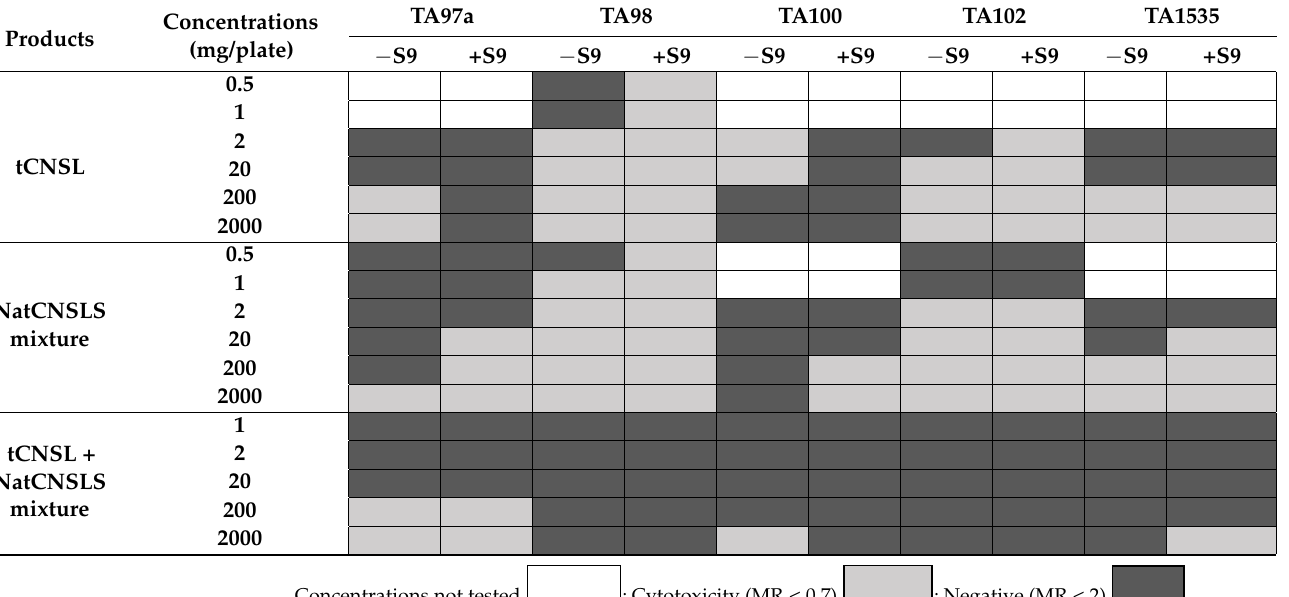
Table 5. Mutagenic activity of tCNSL + NatCNSLS mixture and its constituents (tCNSL and NatC- NSLS mixture) expressed by the mutagenicity ratio (MR) for strains TA97a, TA98, TA100, TA102 and TA1535 in the absence ( − S9) and presence (+S9) of metabolic activation.